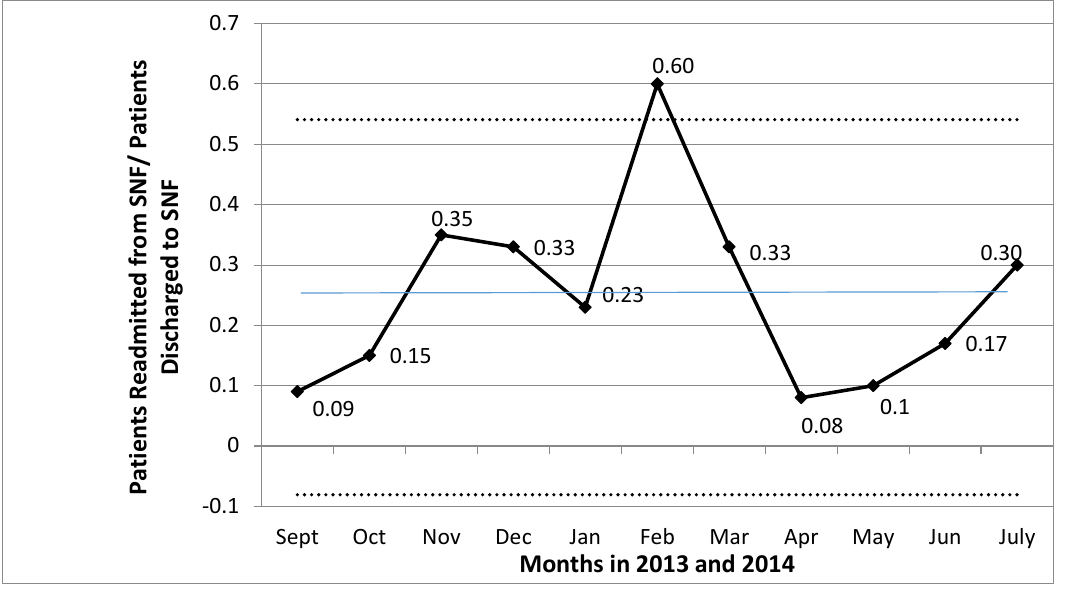
Figure 2. Statistical process control chart (U-chart) of unplanned 30-day readmission rates. Blue horizontal line indicates overall mean rate of readmissions of 24.8%, which was not statistically different from baseline/prior to the intervention. Dotted lines are two standard deviations from the mean.